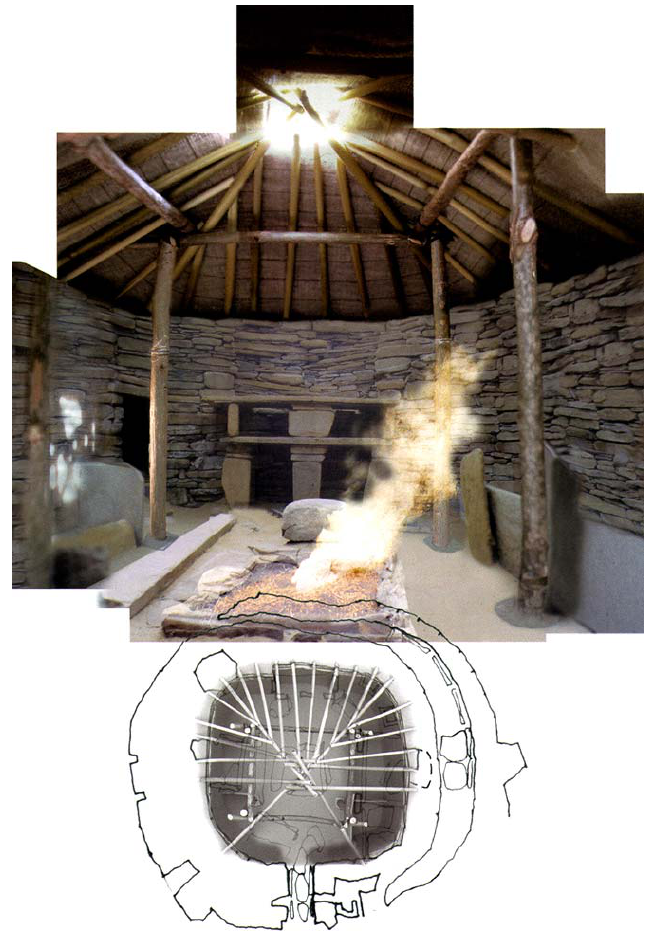
Figure 9. Photomontage and sketch reconstruction of a Neolithic dwelling at Skara Brae, Trevor Garnham and Harry Paticas [43]. Photo: courtesy Trevor